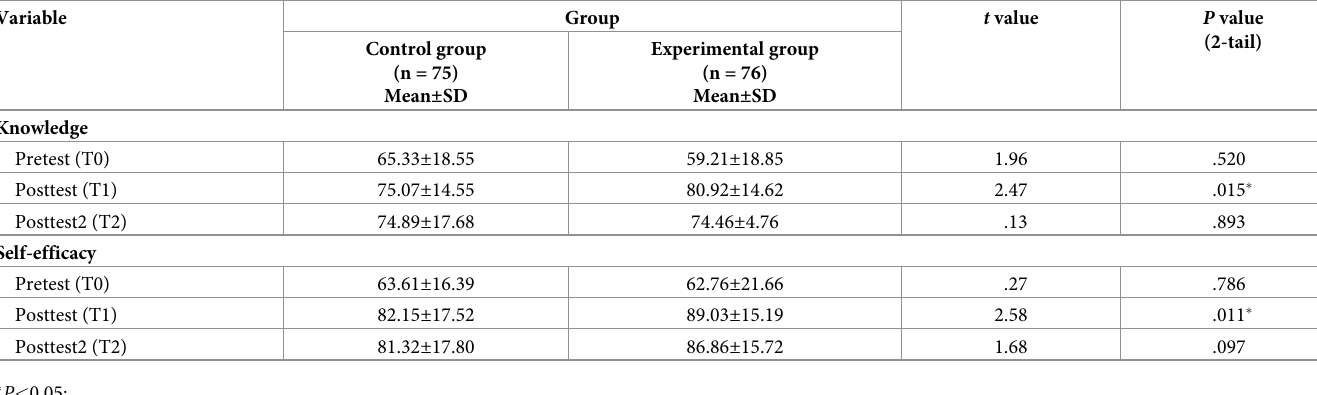
Table 2. Comparison of evidence-based nursing knowledge and self-efficacy in practice between two groups.